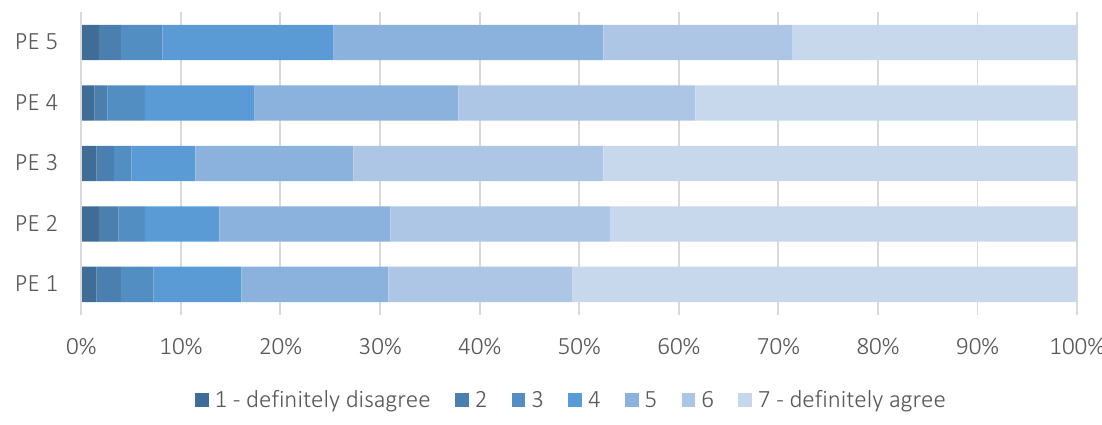
Figure 1. Results for the factor of expected Table 1. Results for the expected performance factor